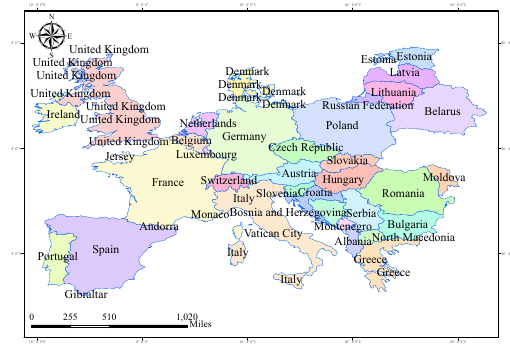
Fig. 1. Location of the study